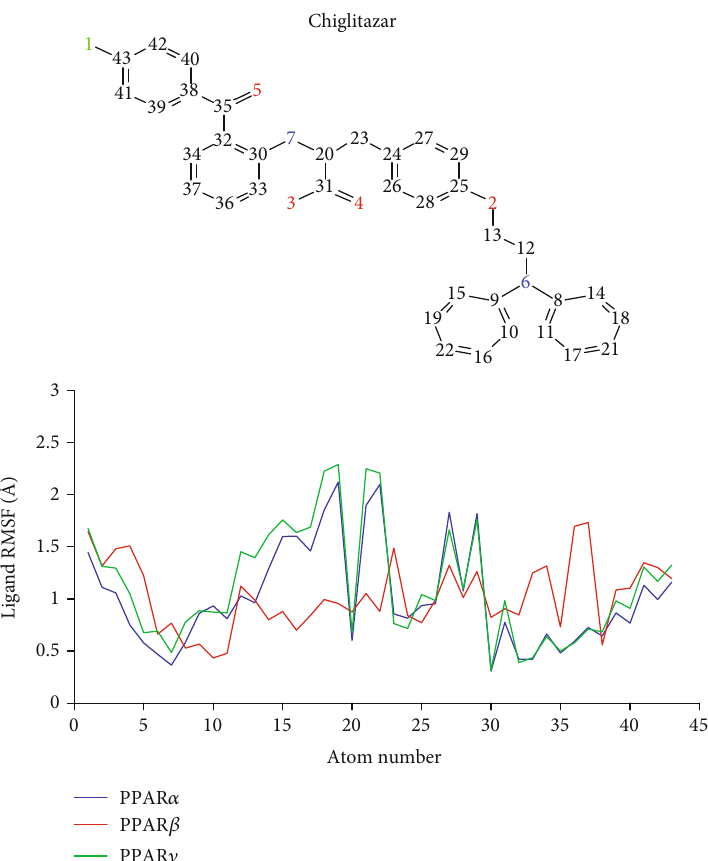
Figure 9: Ligand RMSF diagrams of chiglitazar in complex with PPAR α (red), PPAR β (blue), and PPAR γ (green) in the combined